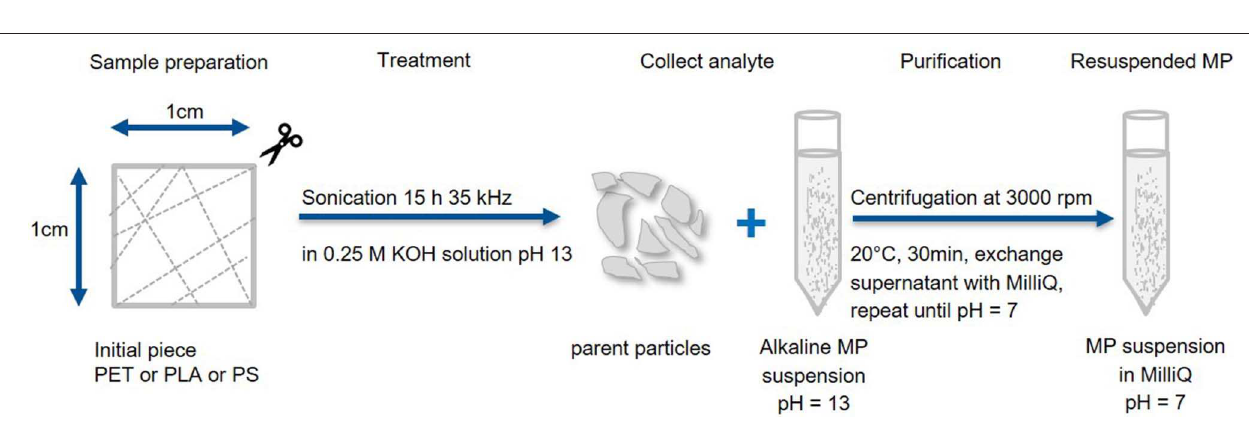
FIGURE 2 | Fragmentation and work up scheme B. Production of large MP fragments with recovery of the parent particles. Particles smaller than 1mm are washed and concentrated in